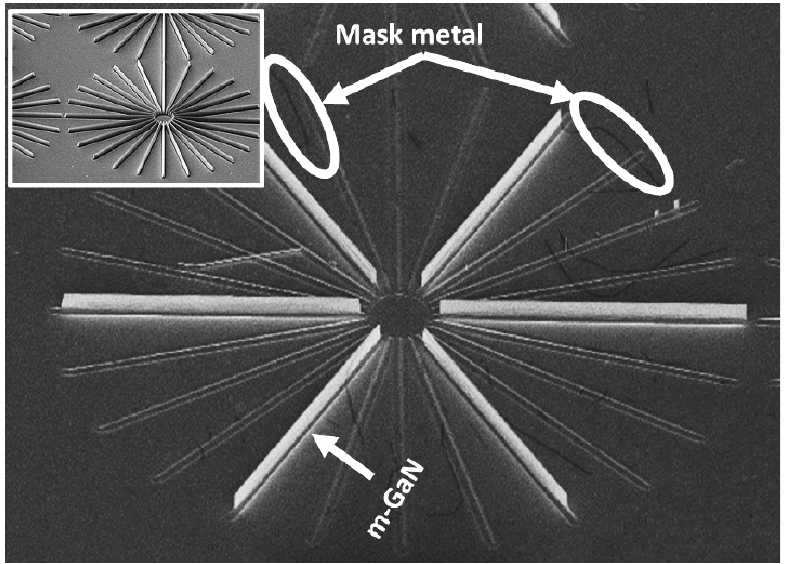
Figure 6. Star shape pattern after 30 min TMAH etching (insert: picture of the same pattern before TMAH etching).